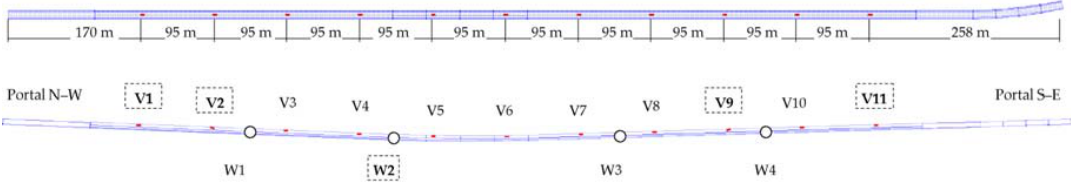
Figure 2. Numerical mesh of the tunnel model.